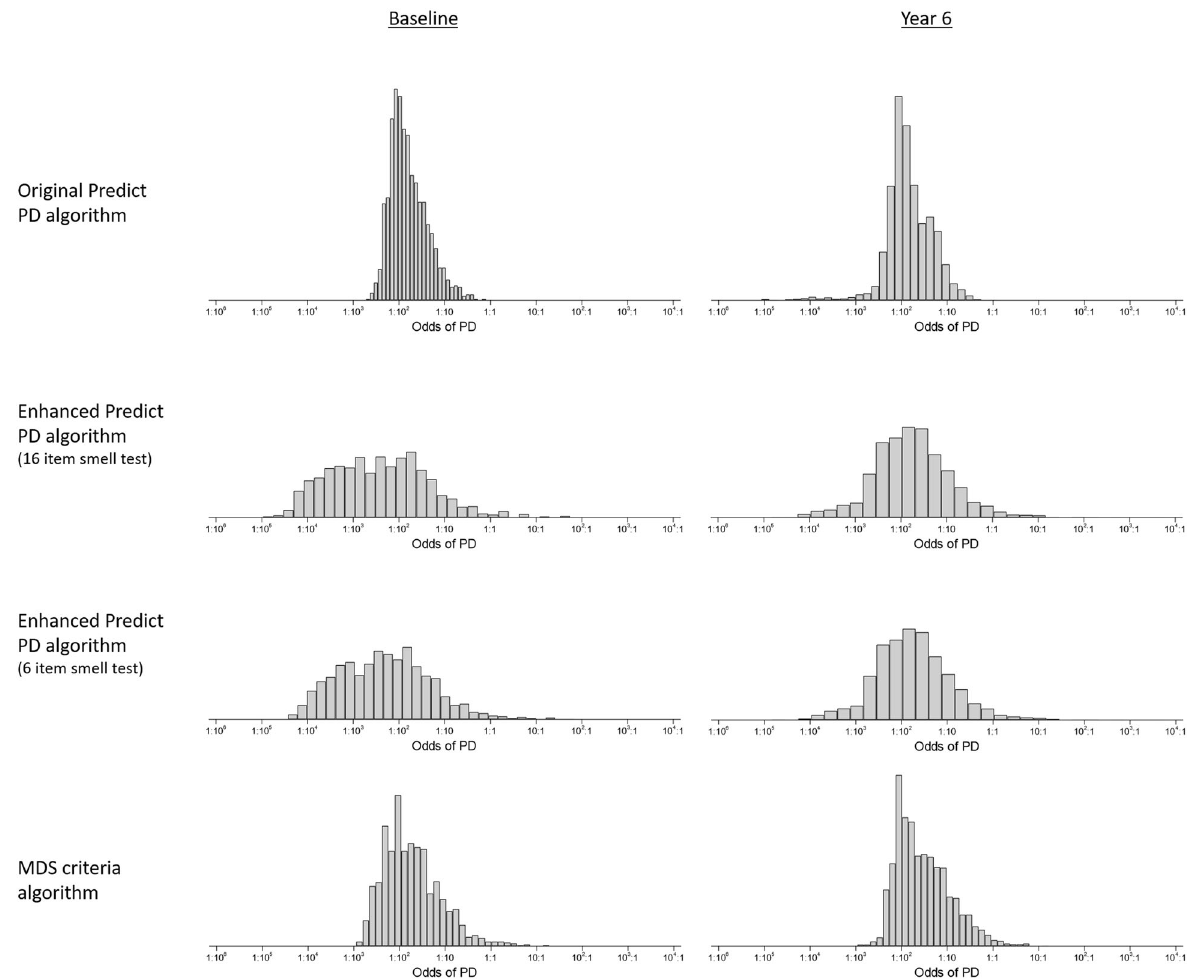
Fig. 1 Histograms of risk scores for PREDICT-PD participants (presented as odds). Left column shows baseline risks and the right column show risks for the latest survey year. Risks calculated using the basic PREDICT-PD algorithm, the enhanced PREDICT-PD algorithm using a 16 item smell test, the enhanced PREDICT-PD algorithm using a 6-item smell test and the MDS criteria algorithm are shown on the fi rst, second, third and fourth rows